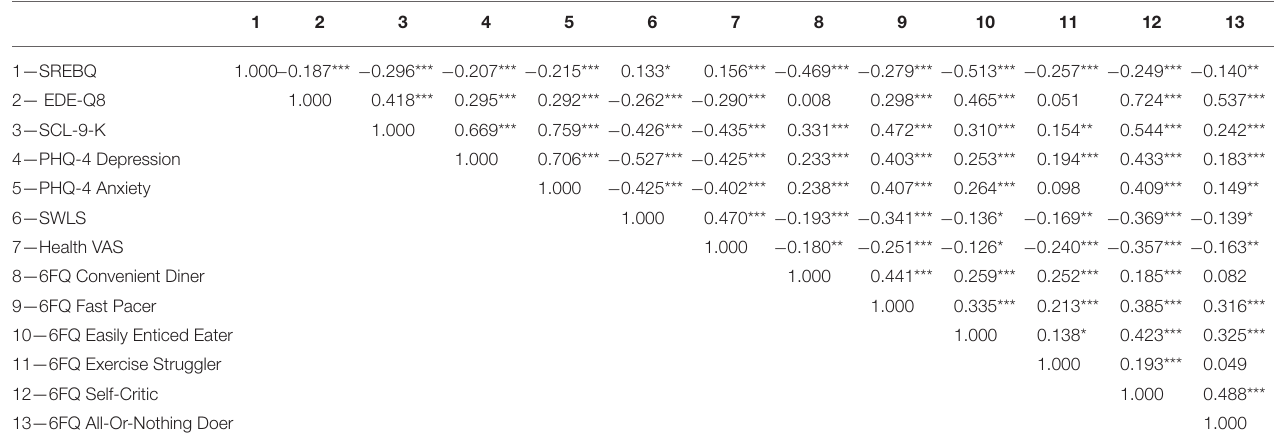
TABLE 5 | Correlations between the Self-Regulation of Eating Behavior Questionnaire and theoretically related scales (Sample